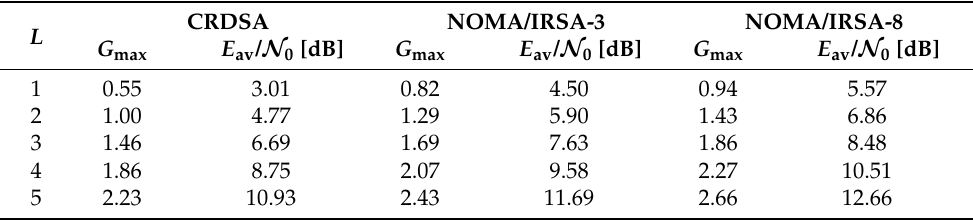
Table 2. Limiting throughput G max and required SNR E av / N 0 as a function of the number L of energy levels in ideal conditions for R = 1 information bits/symbol and assuming the Shannon